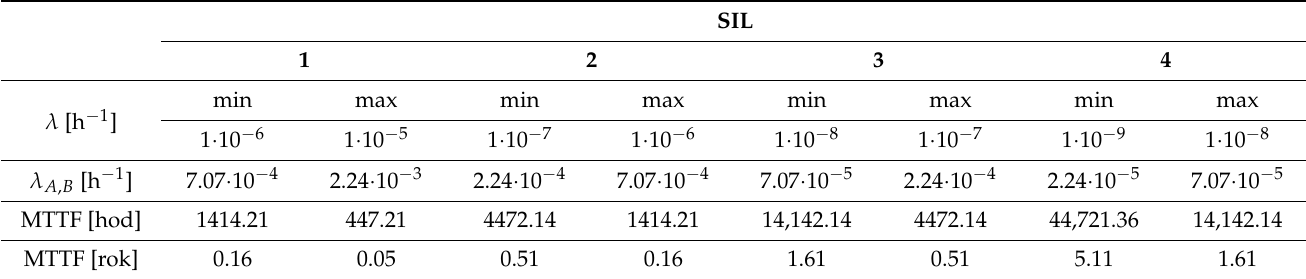
Table 1. The minimum failure rates and MTTFs of channels A and B necessary to achieve SIL 1–4 for fault detection and negation time of 1 h determined according to Equations (4) and (6). SIL